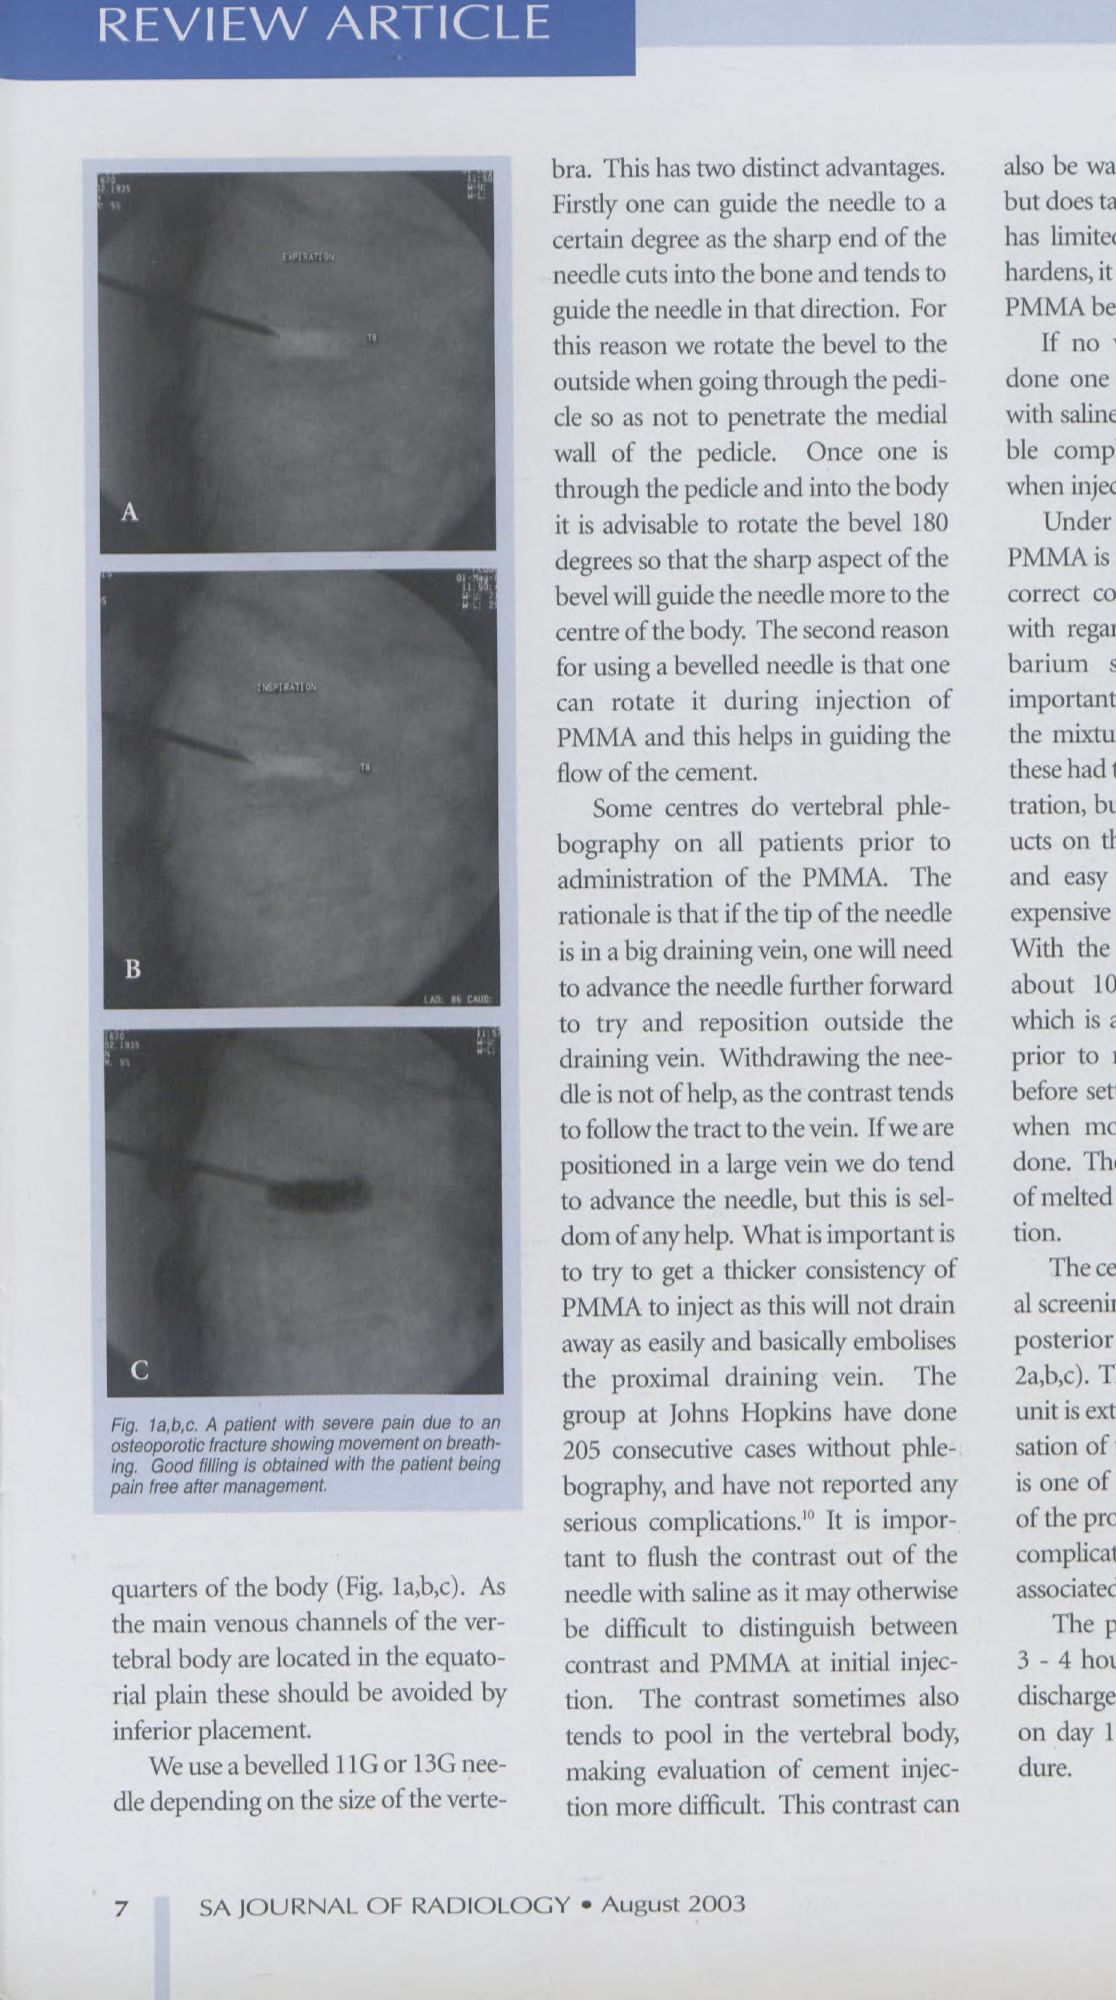
Fig. 1a,b,c. A patient with severe pain due to an osteoporotic fracture showing movement on breath- ing. Good fil/ing is obtained with the patient being pain free after